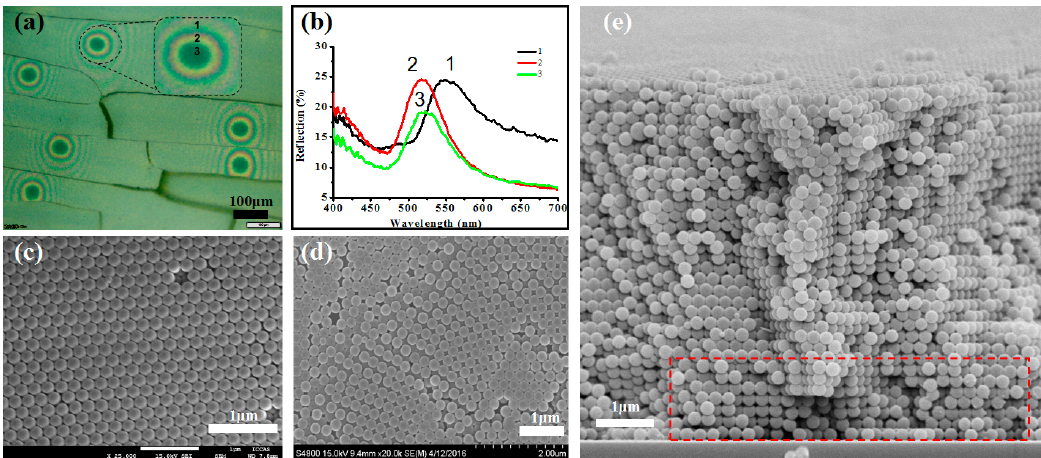
Figure 2. ( a ) Optical microscope image of the assembly sample with eye pattern; ( b ) UV-vis spectra of different parts of the peacock eye pattern structure; ( c , d ) SEM images of assembled photonic crystals (PCs) with close-packed arrangement ( c ) and non-closed packed region ( d ); ( e ) Cross section SEM image of sample in red rectangle part indicates the transverse of yellow and green connection part of the eye pattern.